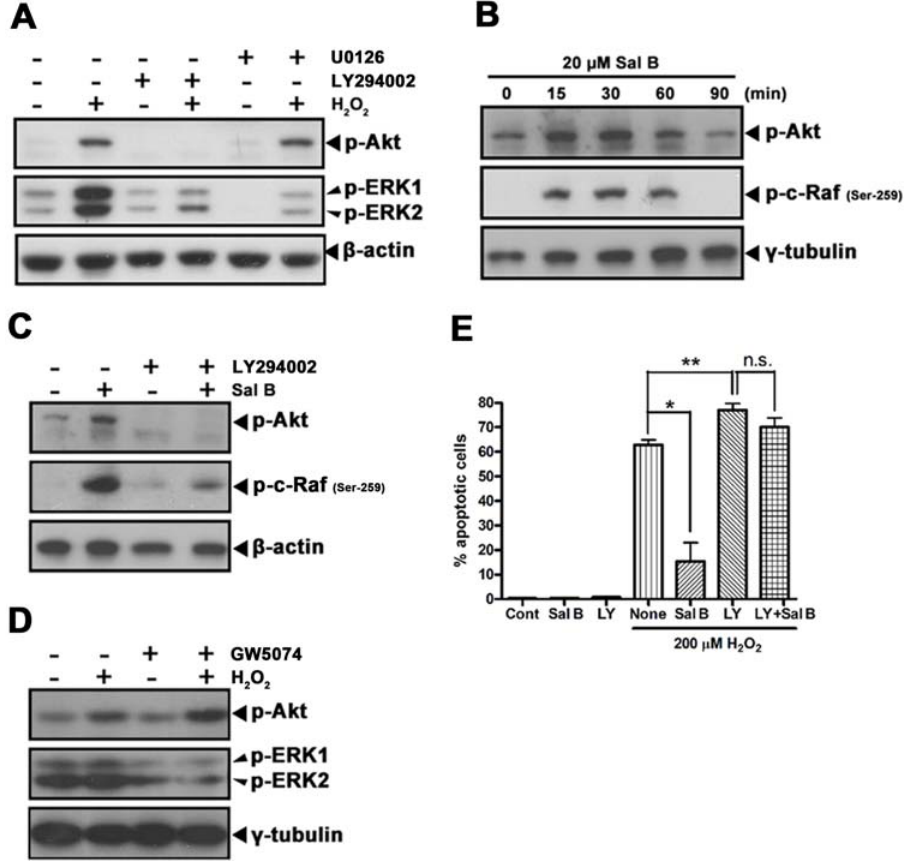
Figure 3. Role of PI3K signaling. (A) Effects of PI3K or MEK inhibition on phosphorylated Akt (Ser-473) and phosphorylated ERK1/2 expression in the presence or absence of H 2 O 2 (200 m M). rCMECs were incubated with LY294002 (50 m M) or U0126 (10 m M) for 1 h and then exposed to H 2 O 2 for 30 min. Blot shown is representative of at least three independent experiments. (B) Phosphorylated Akt (Ser-473) and phosphorylated c-Raf (Ser-259) expressions in rCMECs incubated with Sal B (20 m M) for the indicated times. (C) Effect of PI3K inhibition on phosphorylated Akt (Ser-473) and phosphorylated c-Raf (Ser-259) expressions induced by Sal B. rCMECs were incubated with LY294002 (50 m M) and/or Sal B (20 m M) for 1 h. (D) Effect of c-Raf inhibition on phosphorylated Akt (Ser-473) and phosphorylated ERK1/2 activation induced by H 2 O 2 . rCMECs were incubated with GW5074 (5 m M) and/or H 2 O 2 (200 m M) for 1 h. (E) Effect of PI3K inhibition on H 2 O 2 -induced apoptosis in the presence or absence of Sal B (20 m M). rCMECs were incubated with LY294002 (50 m M) and/or Sal B (20 m M) for 1 h and then exposed to H 2 O 2 for 12 h. LY, indicates LY294002. S, indicates Sal B. * P , 0.05; ** P , 0.01 versus H 2 O 2 alone; n.s., not significant. Data are representative of three independent experiments.